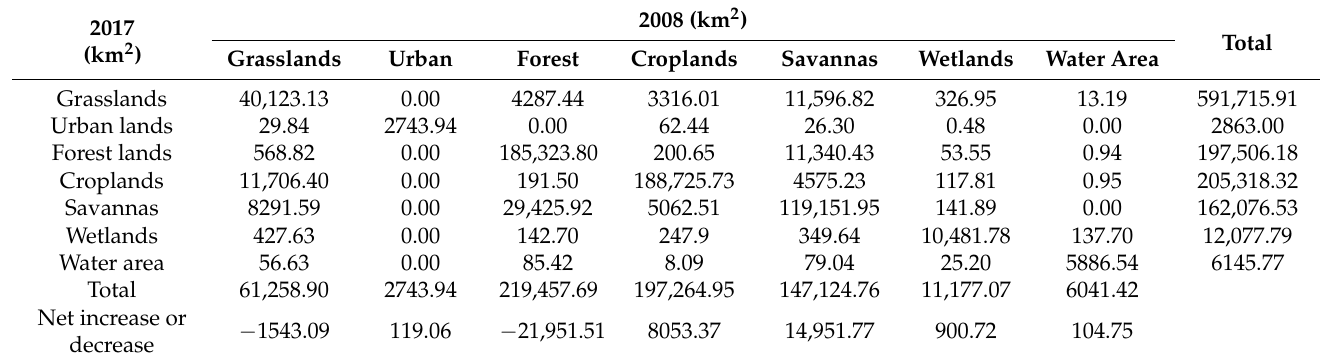
Table 3. Comparison of land use change and the net change rate in the basin in 2008 and